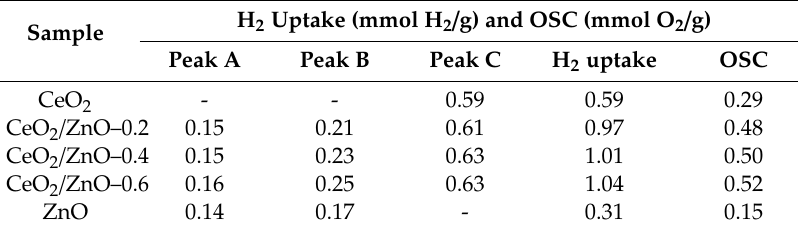
Table 3. Redox features of CeO 2 and CeO 2 / ZnO samples.